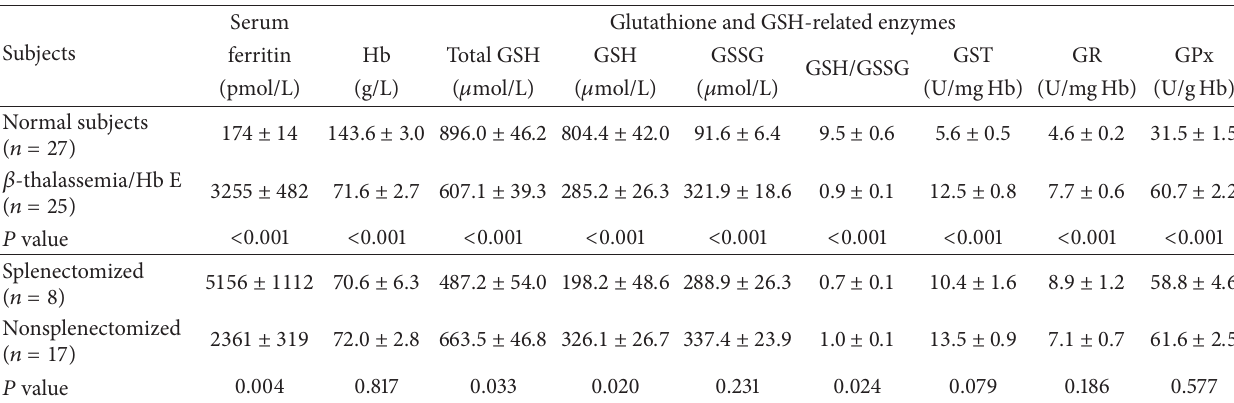
Table 2: Serum ferritin, glutathione concentration, redox ratio (GSH/GSSG), and GSH-related enzyme activities (GST, GR, GPx) of normal subjects and 𝛽 -thalassemia/Hb E patients (mean ± SEM).